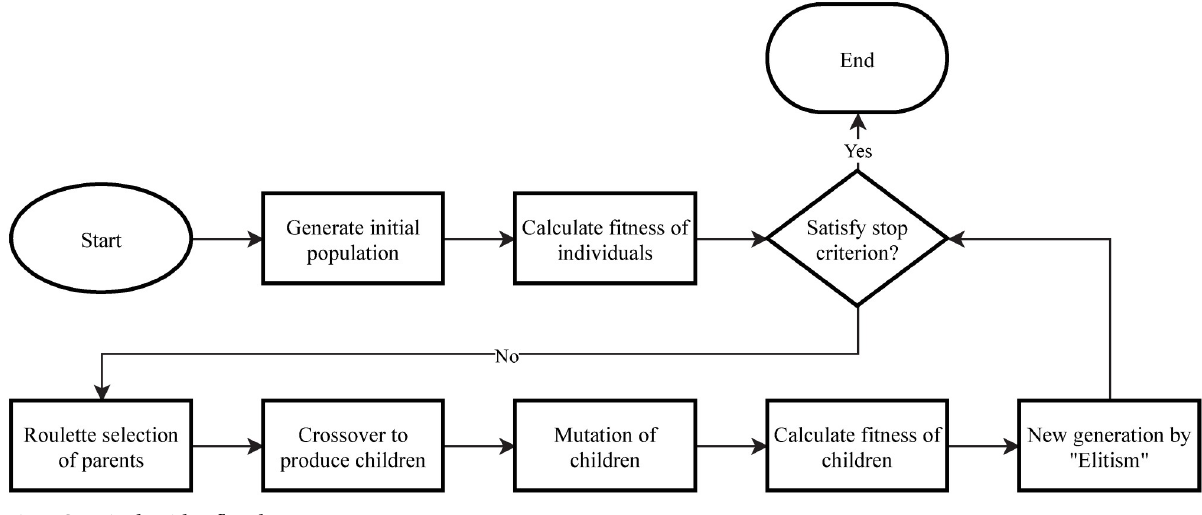
Fig 1. Genetic algorithm